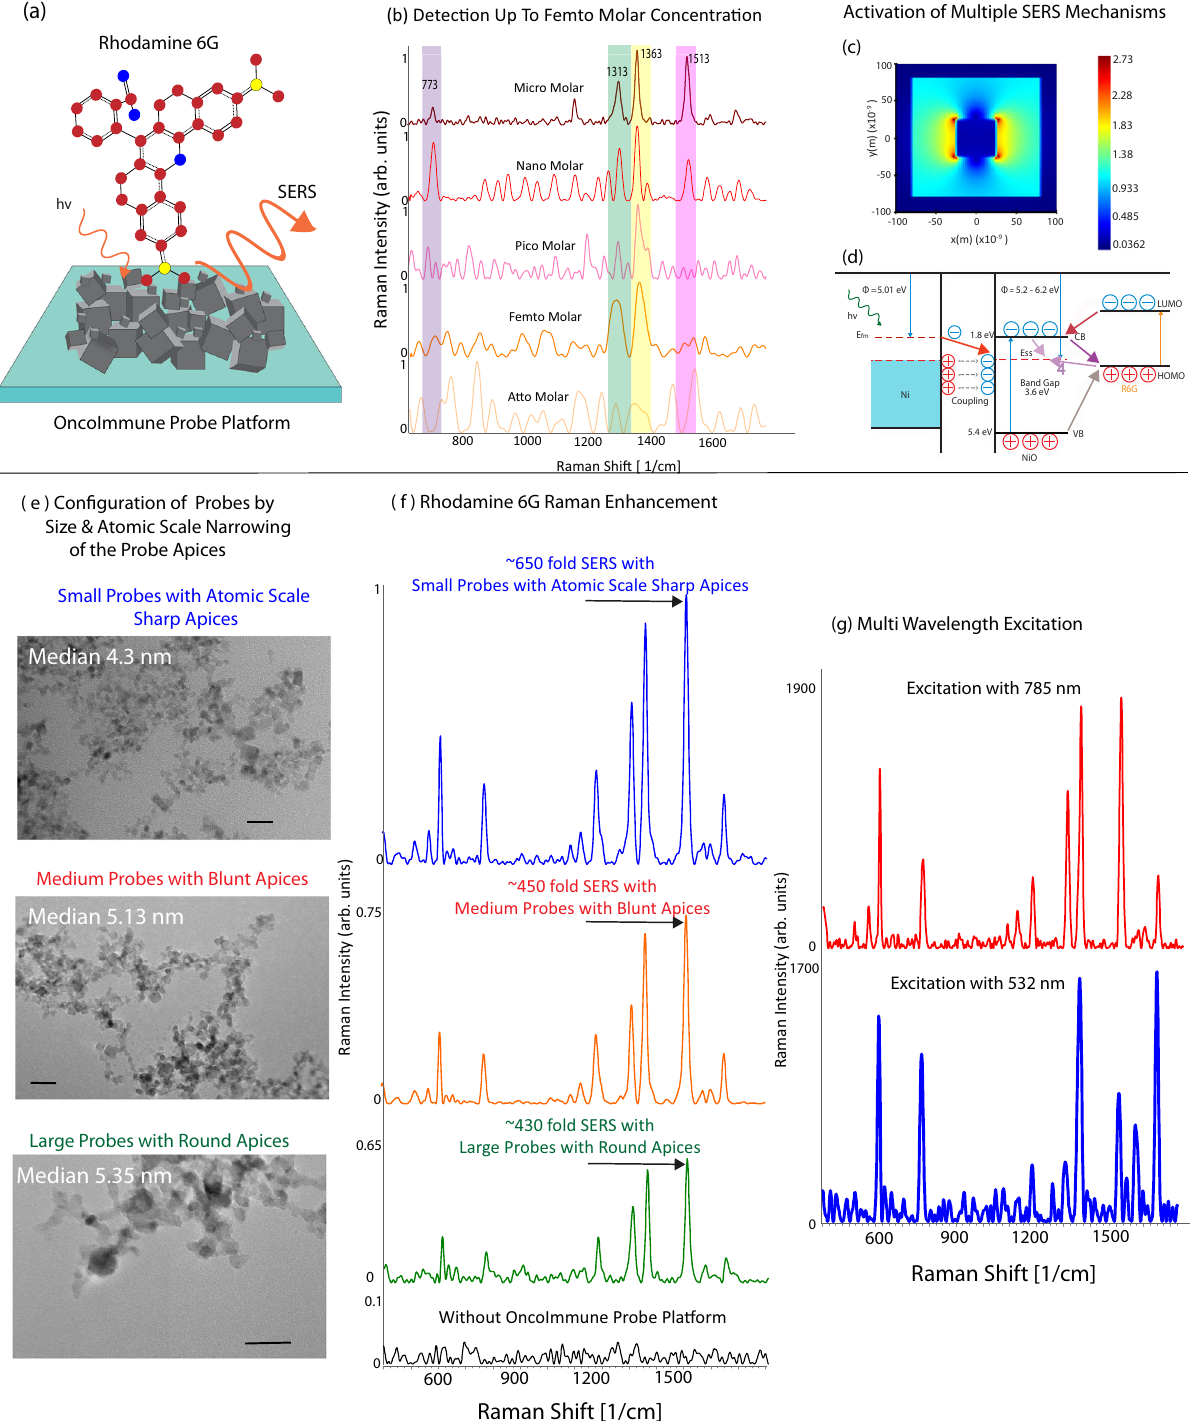
Fig. 3 | Molecular level detection with OncoImmune probe platform. a Schematic representation of Rhodamine 6G analyte on OncoImmune probe platform. b Detection of analyte at femtomolar concentration was achieved with nanoprobes with sharp apices (representative spectra at micromolar — maroon, nanomolar — red, picomolar — pink, femtomolar — orange, attomolar — yellow. Demonstration of multiple SERS mechanisms with ( c ) Finite-Difference-Time- Domain (FDTD) simulation of Ni probes demonstrating the presence of localized surface plasmon resonance and ( d ) schematic representation of charge transfer